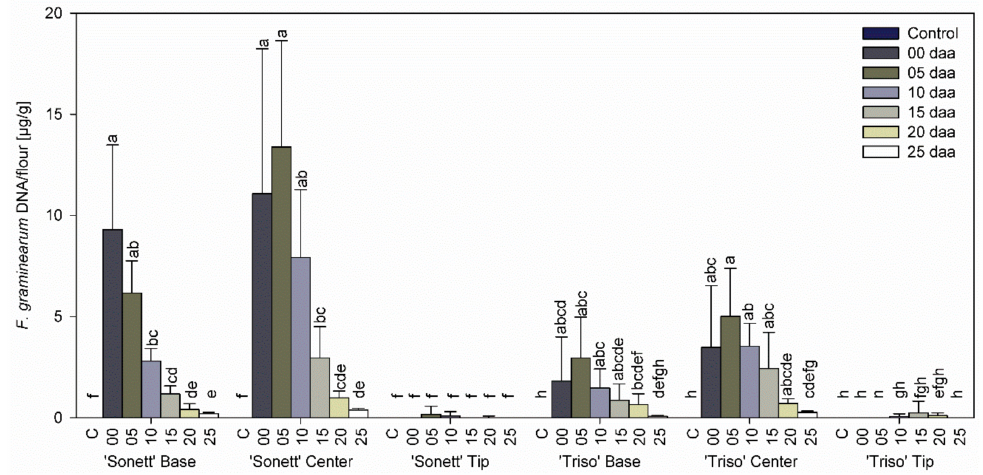
Figure 2. Fungal DNA content in the tips, centers, and bases of the spikes of spring wheat varieties ‘Sonett’ and ‘Triso’ after inoculation of the central spikelets of the spike with Fusarium graminearum at different days after anthesis (daa), Kruskal–Wallis test ( p < 0.0001); n = 6; treatments with the same letters at the level of the variety are not significantly different.